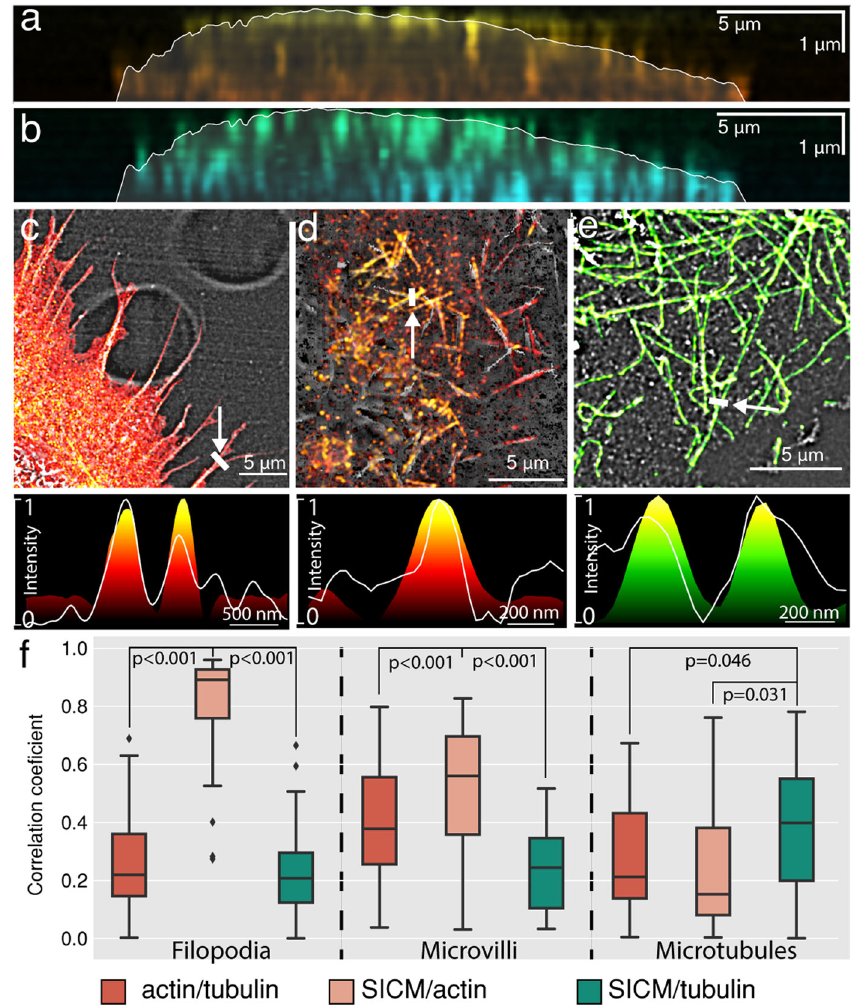
Fig. 5 Volumetric distribution of cytoskeletal components from correlative SICM-3D-SOFI images. Vertical cross-sections of actin ( a ) and tubulin ( b ) in a fi xed COS-7 cell marked in Figs. 3c and 4a overlaid with the SICM topography displayed as a semi-transparent contour. Correlative imaging of different cellular components resolved by SICM: fi lopodia overlaid with fl uorescently labeled f-actin from 3D-SOFI ( c ), microvilli overlaid with fl uorescently labeled f- actin from 3D-SOFI ( d ) and microtubules of chemically unroofed COS-7 cells overlaid with fl uorescently labeled tubulin from 3D-SOFI ( e ). Normalized intensity pro fi les are displayed below each image. The arrows in c – e are guides for the eye to indicate the locations of cross sections. For overlays only, the intensity values of SOFI images were projected on spatially fi ltered SICM images for a better structural representation. f Normalized Pearson cross- correlation coef fi cients of normalized height and intensity cross-sections for both SICM topography and fl uorescence channels. Cross-sections ( N = 30) were manually selected (Supplementary Fig. 13) from the SICM image for each of the features in 3 different correlative images. Correlation coef fi cients were measured on fi lipodia structures, microvilli structures and microtubules. Signi fi cantly higher ( p < 0.05, two-sided t -test) correlation values were identi fi ed for fi lopodia(SICM)/actin (2D-SOFI), microvilli (SICM)/actin (3D-SOFI) and microtubules (SICM)/tubulin (3D-SOFI). For all comparisons, p values are shown in the upper part of f panel. The lower and upper bounds of the box plot correspond to the fi rst and third quartiles, while the middle line shows the median. The upper and lower whiskers extend no further than 1.5 times of the interquartile range (IQR) from upper and lower bounds. Points outside this range are de fi ned as outliers. Raw source data are provided in the Source Data File. This fi gure is representative of more than 10 correlative SICM and 2-color 2D/3D SOFI single-cell images obtained from at least two independent lipids 47 , lipid-rafts 48 , behavior of voltage-gated ion channels 49 , etc. While there are some remaining technological challenges in